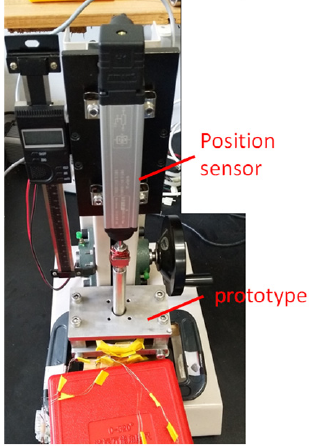
Figure 13. The dynamic characteristics testing platform.